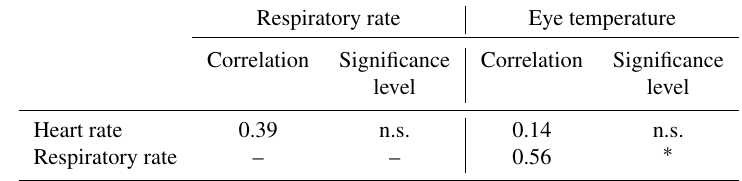
Table 3. Pearson correlations between the stress parameters: heart rate, respiratory rate and eye